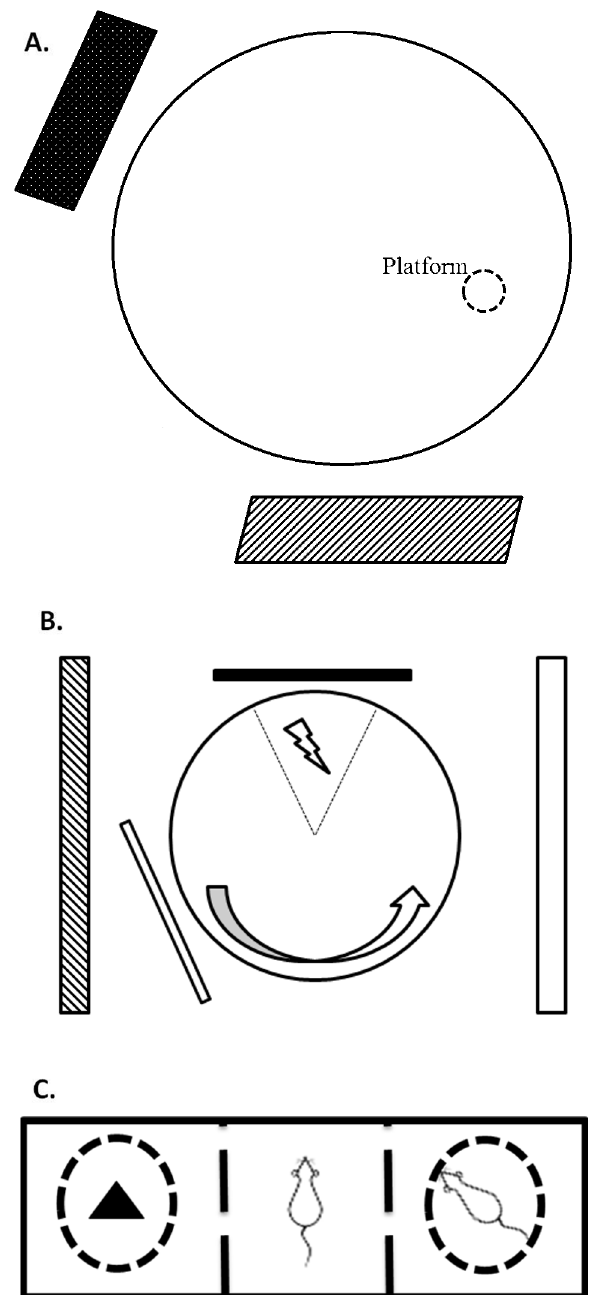
Figure 1. Diagrams of the behavioral set ups used in this manuscript. ( A ) Morris water maze. ( B ) Place avoidance arena. ( C ) Three chambered social choice